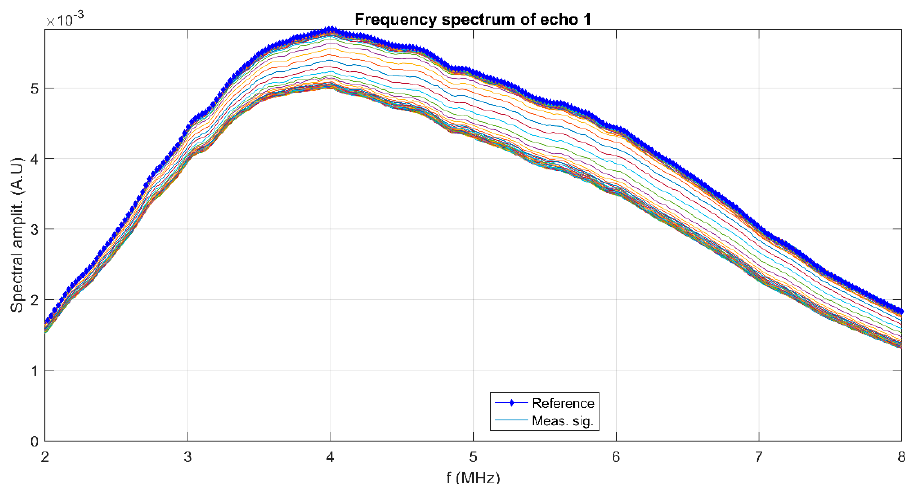
Figure 4. Frequency spectrum of the first transmitted echo for the reference fluid ( ◊ ) and all recorded signals (-).